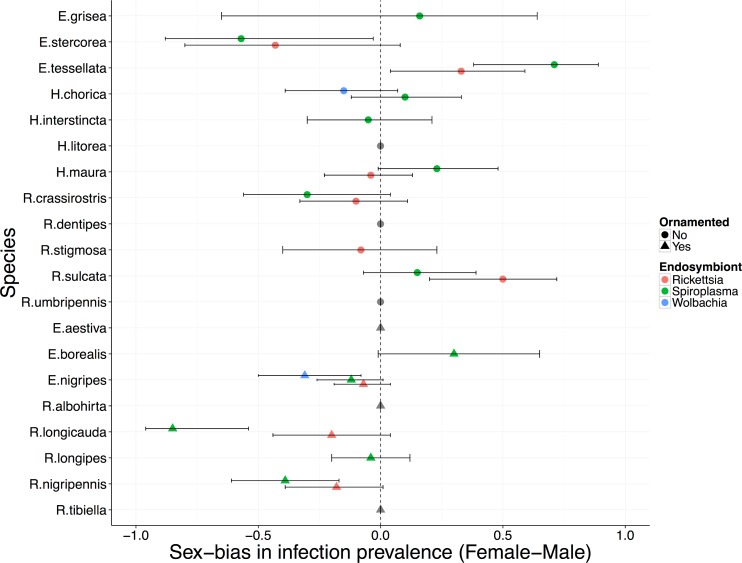
Forest plot displaying the sex-bias in endosymbiont prevalence across dance fly host species from three genera (Empis, Hilara and Rhamphomyia) with and without female-specific ornamentation.Circles indicate host species without female ornamentation, while triangles indicate species with ornaments. The endosymbiont taxa are identified by colour: red = Rickettsia, green = Spiroplasma, blue = Wolbachia. The error bars are the 95% confidence intervals around the sex-bias (difference in prevalence between males and females) calculated using the Wilson procedure with continuity correction.